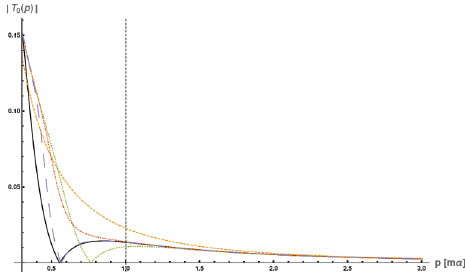
Figure 3. The modulus of the Coulomb S -wave PWA given by the exact result (black solid line) is compared with those obtained by applying the unitarization formula up to order O ( α n ) in the (cid:80) n V ( i ) calculation of V 0 = ( p ). The lines with i = 1 0 n = 1 , 3, 5 and 7 are given by the orange dashed, green dotted, red dash-dotted and magenta long-dashed lines, respectively. In the figure energy units are taken such that m α = 1, with the vertical line indicating this value for p